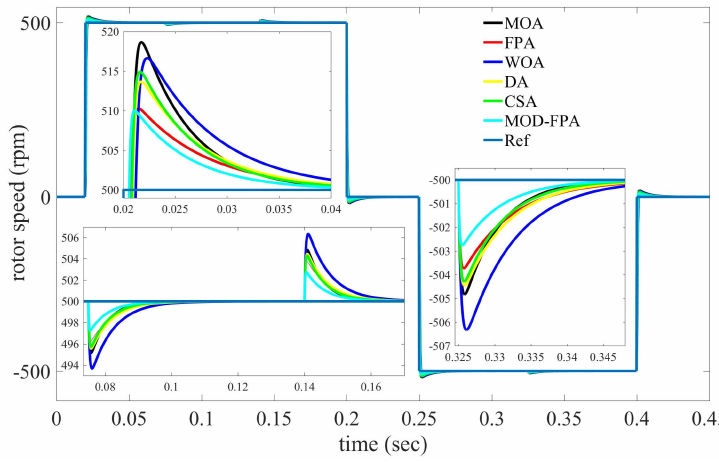
Figure 11. Simulation result for speed tracking task, Case